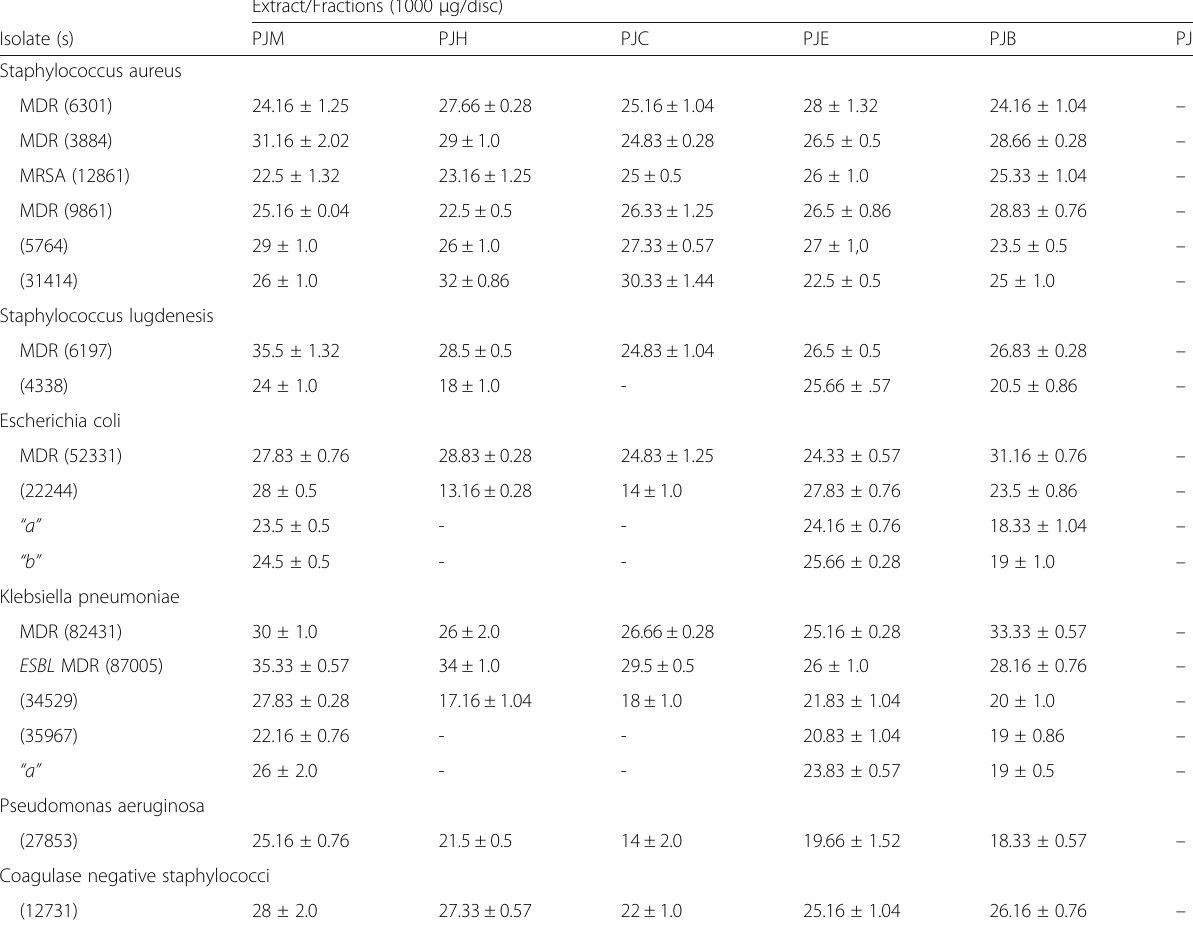
Table 4 Antibacterial screening of P. jacquemontiana extract against gram positive and gram negative bacteria Extract/Fractions (1000 μ